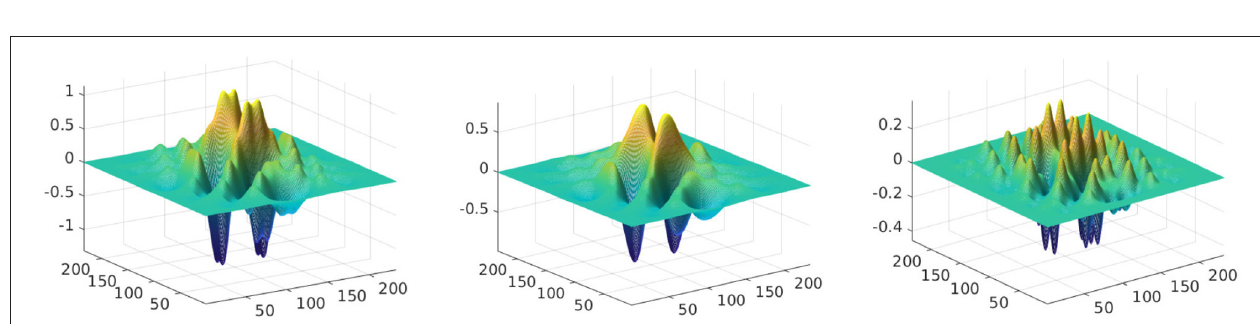
FIGURE 6 | Full-, long- and short-range components of the multi-Slater tensor. Slater kernels with λ placed in the nodes of a 12